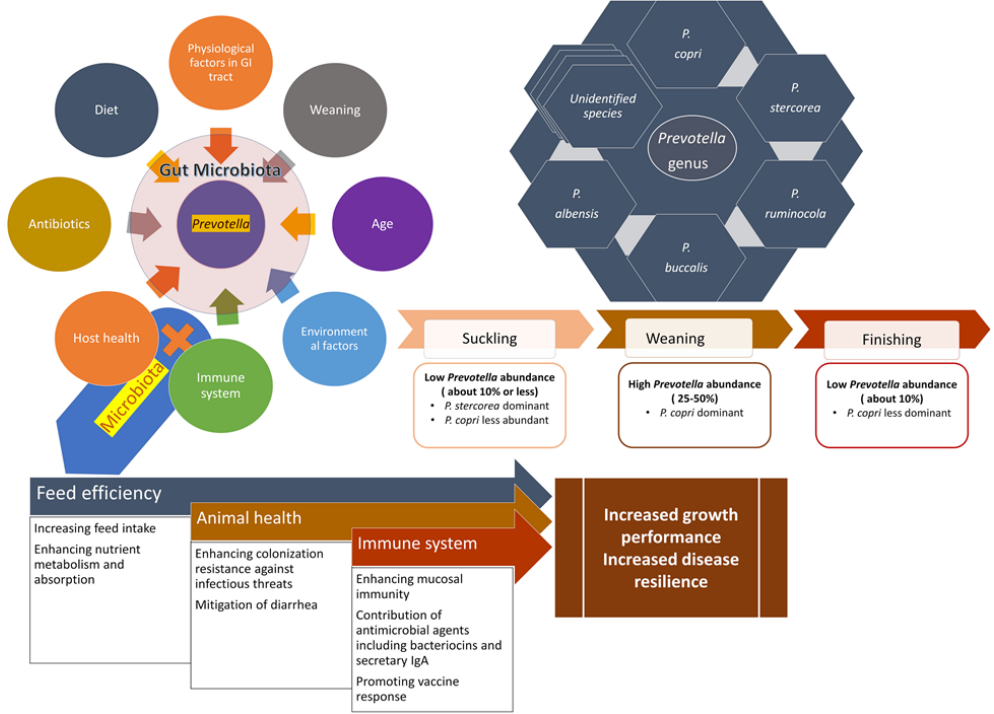
Figure 1. Schematic overview of the factors influencing the microbiota in gastrointestinal tract (GIT)